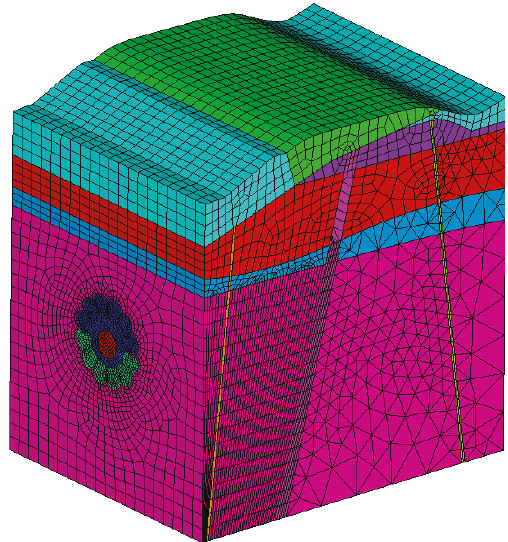
Figure 4: 3D computation mode.